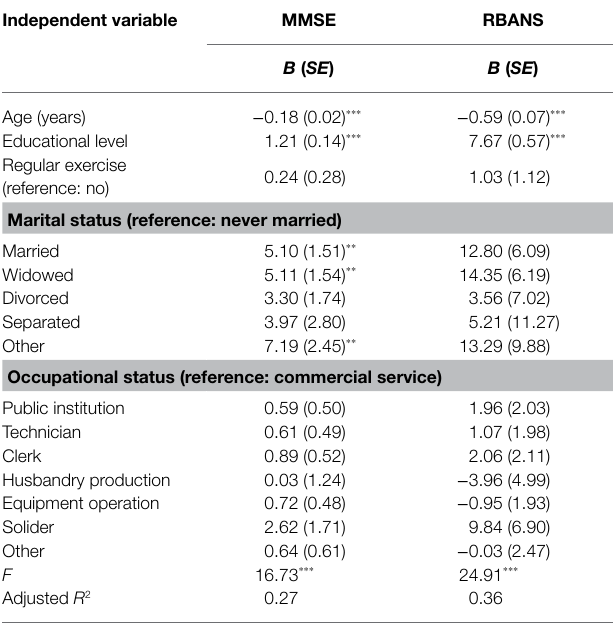
TABLE 4 | Multivariate linear regression of factors related to the Mini-Mental State Examination (MMSE) and Repeatable Battery for the Assessment of Neuropsychological Status